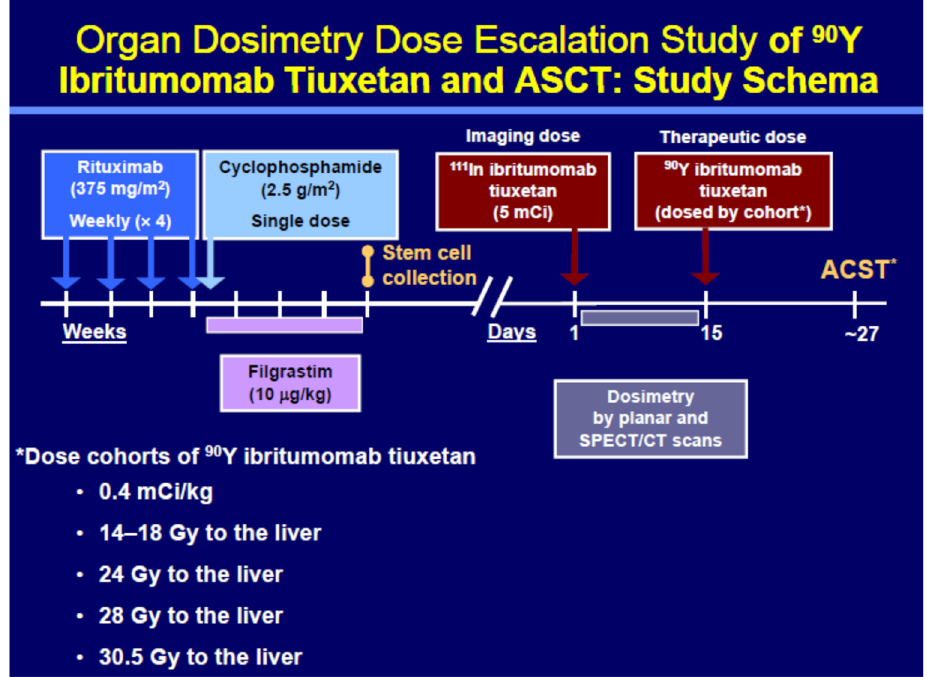
Figure 1. Study schema. Patients had to have adequate stem cell harvests to move forward to the imaging and 90 Y ibritumomab tiuxetan therapy arm.